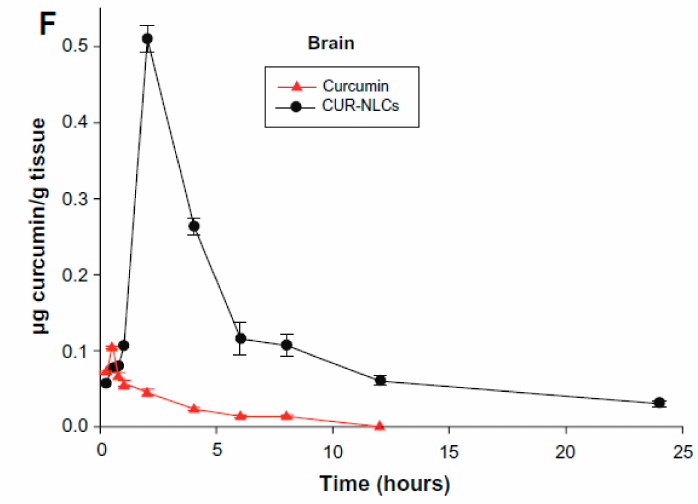
Figure 6. Curcumin nanostructured lipid carrier (Cur-NLC) tissue concentration in the brain with time